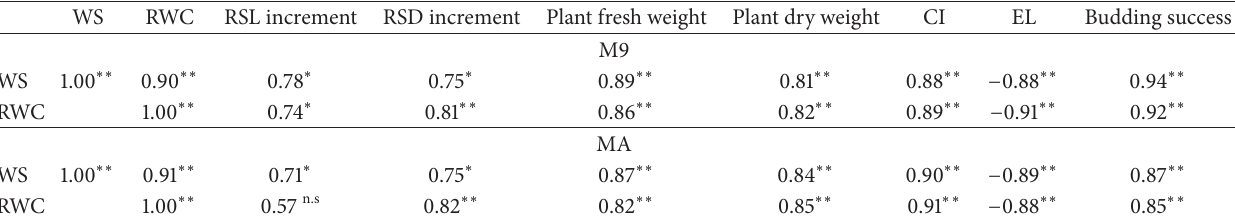
Table 3: Relationships between some parameters in M9 apple and MA quince rootstock.